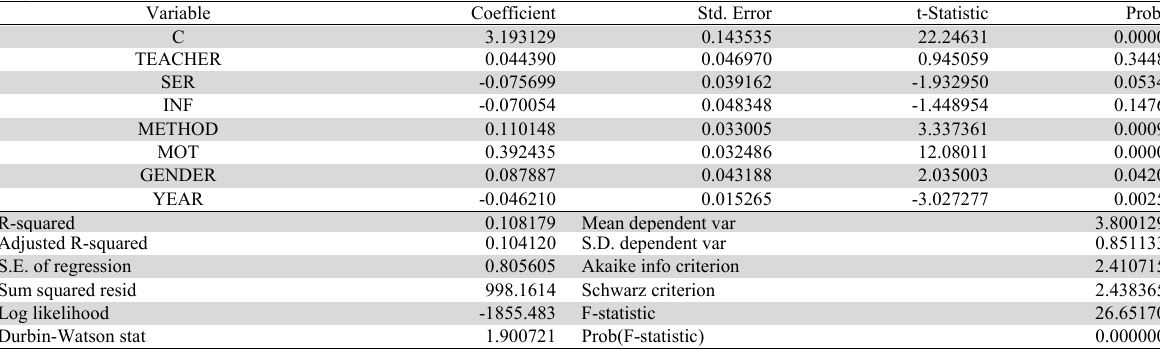
Regression analysis